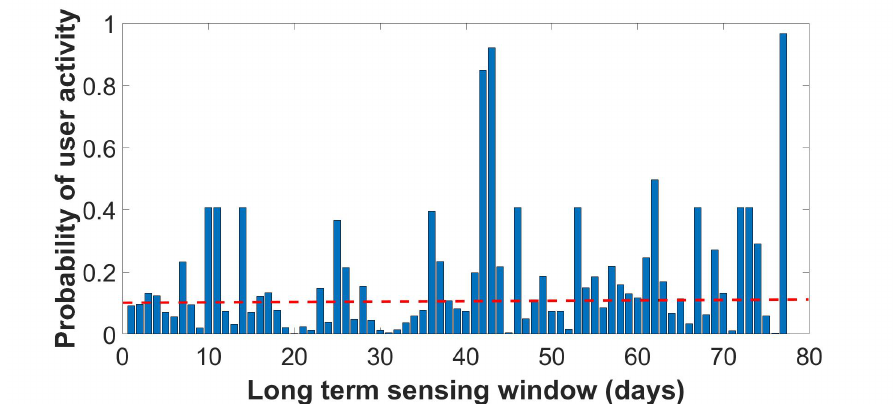
Figure 7. Probability of the selected least active user during sensing time